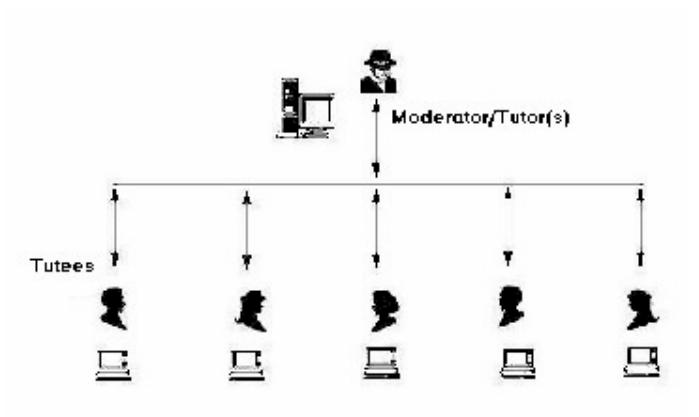
Figure 1. Communication within tutorials via the